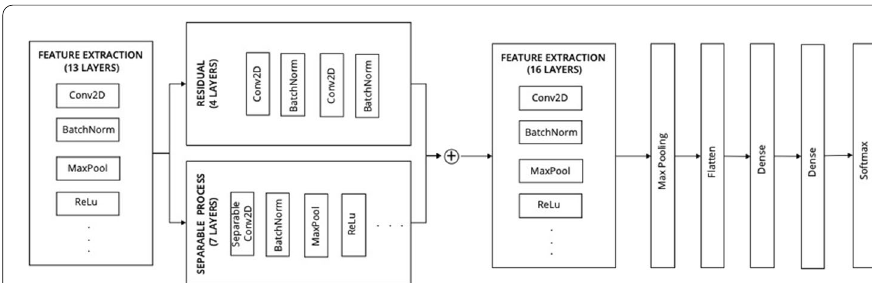
Fig. 2 Architecture with separable convolution and dense layers (ARCH-2)